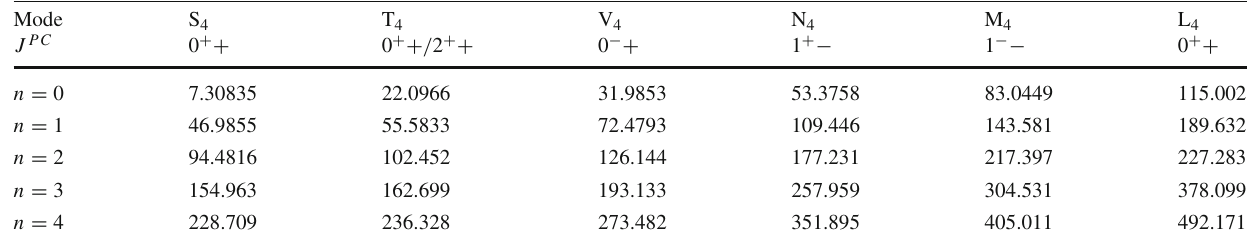
Table 2 Glueball mass spectrum m 2 n of AdS 7 in the units of r 2